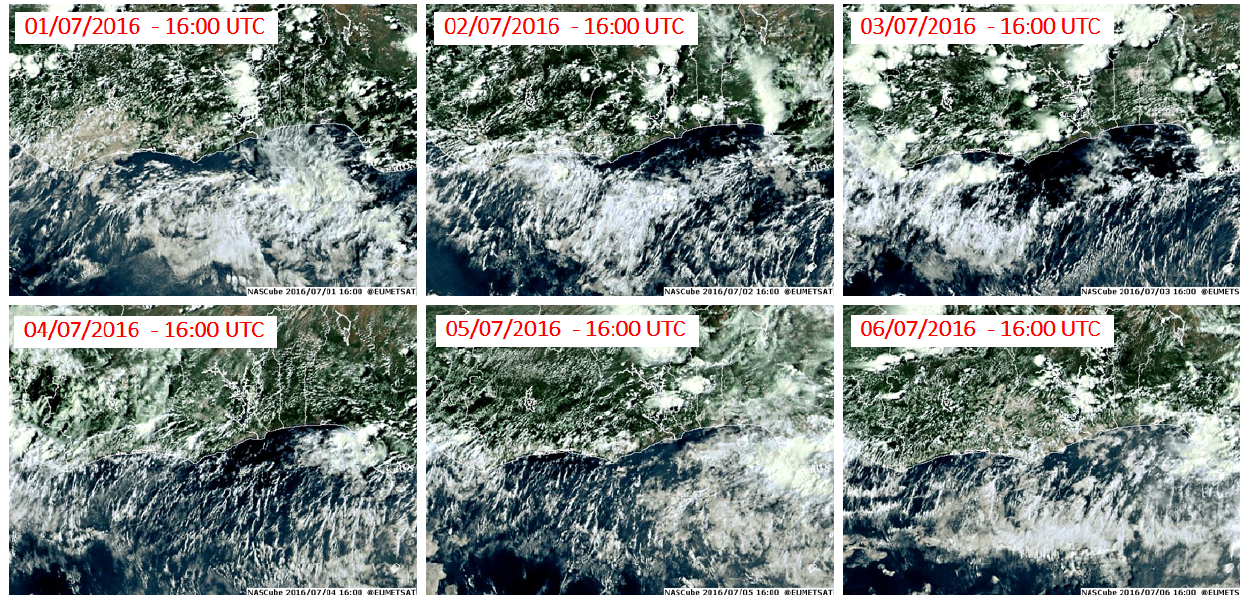
Figure A6. Images by the Spinning Enhanced Visible and Infra-Red Imager (SEVIRI) provided by EuMetSat and NAScube over the studied domain at 16:00UTC for the period 1–6 July 2016.